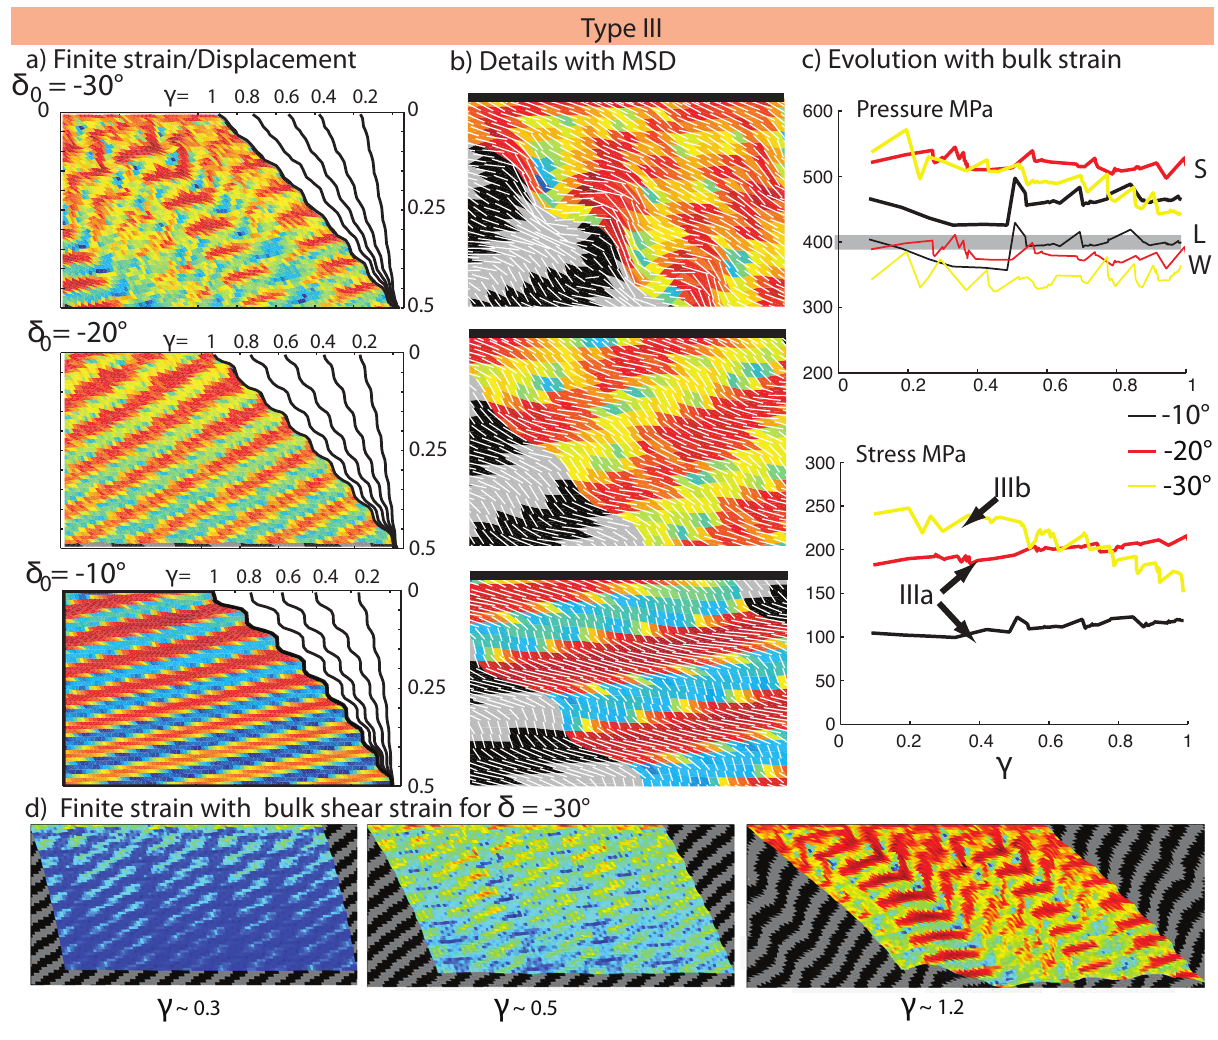
Fig. 6. Type III (a) Finite strain (colour scale) is maximum in weak layers and distributed among small-scale folds at all depths. The deformed profiles for γ respectively equal to 0.2, 0.4, 0.6, 0.8 and 1 indicate no localisation with time, as displacement rates are roughly constant with increasing bulk strain. (b) MSD (white lines) indicates pure thickening in strong layers. (c) Pressure in weak layers (W, thin line) is very close to lithostatic pressure (L) while pressure in strong layers (S, thick line) is higher than lithostatic. Evolution of deviatoric stresses discriminates between Type IIIa and IIIb. (d) δ 0 = − 30 ◦ model is affected by kink bands that develop at the onset of strain